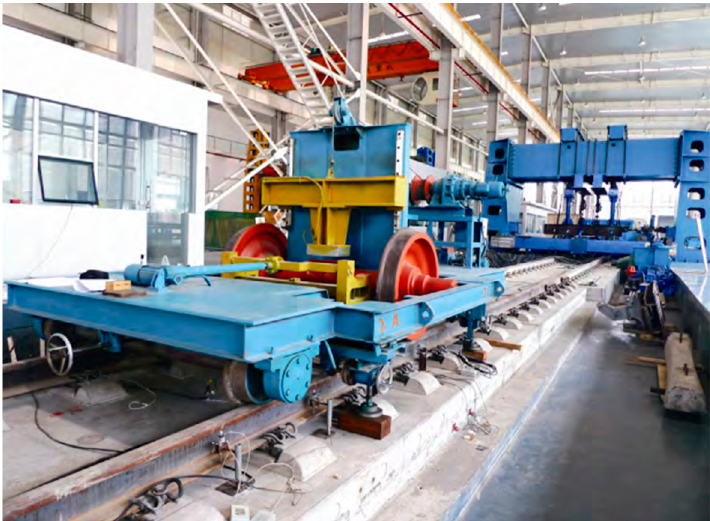
Figure 14. CRTS Ⅲ SBT subgrade full-scale model test platform and axle falling impact device. Figure 14. CRTSIII SBT subgrade full-scale model test platform and axle falling impact device.